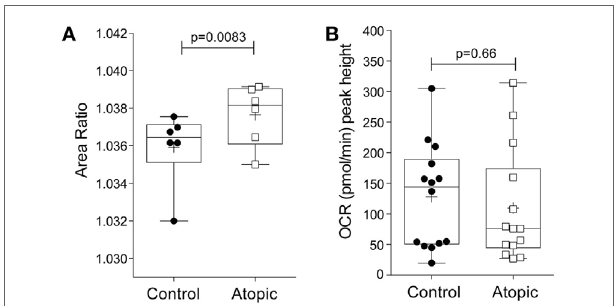
FigUre 4 | Morpho-rheological properties and oxygen consumption rates in eosinophils from atopic and non-atopic subjects. (a) RT-DC was performed on freshly isolated eosinophils from non-atopic volunteers (controls) and atopic volunteers to calculate the area ratio, as described in Section “Materials and Methods.” Box-and-whiskers plot shows median ± range of six independent experiments with mean shown as + , * p < 0.05 compared with non-atopic controls (Student’s t test). (b) Comparison of the peak height OCR by eosinophils from non-atopic and atopic subjects primed with IL-5 (10 ng/ml) for 15 min and then stimulated with fMLP (100 nM). Box-and- whiskers plot shows median ± range of 14 independent experiments with mean shown as + , * p < 0.05 compared with non-atopic controls (Mann– Whitney test).